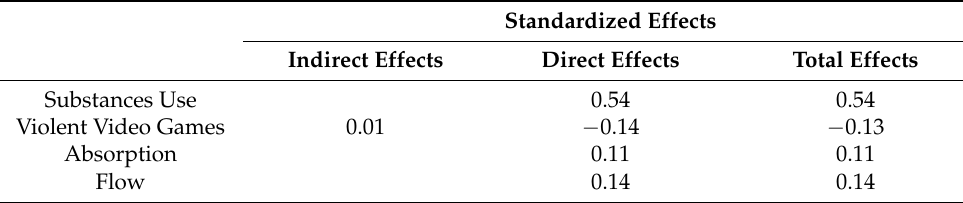
Figure 2. Predictive model of CPV towards fathers (final model). Rectangles represent observed variables and ovals represent latent variables. Values listed are standardized coefficients. * p < 0.05. ** p < 0.01 *** p < 0.001. Table 4. Standardized effects of substance use, violent video games and engagement on CPV towards fathers (final